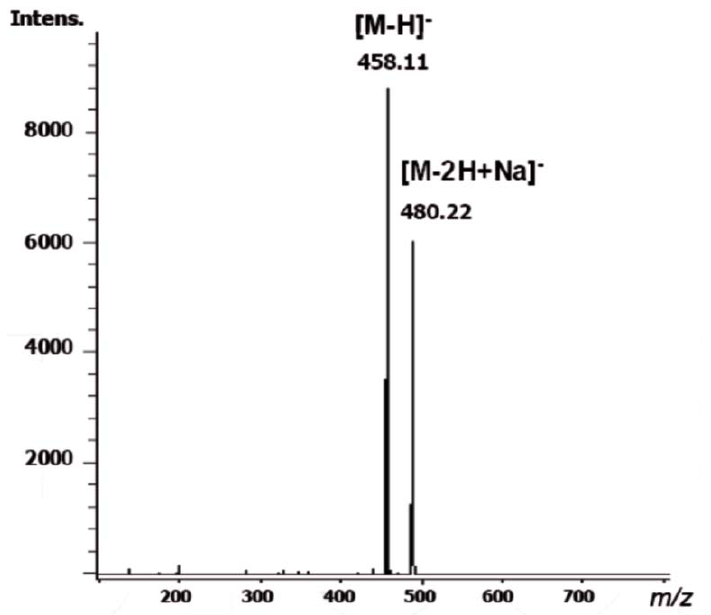
Figure 2. Fully automated chip (-) nanoESI HCT CID MS of monosulfated standard CS disaccharide having the composition [4,5- Δ -GlcA-GalNAc] (6S). Solvent: MeOH; chipESI: -1.4 kV; capillary exit: -50 V. Back nitrogen pressure 0.30 p.s.i. Nitrogen nebullizer on MS at 50